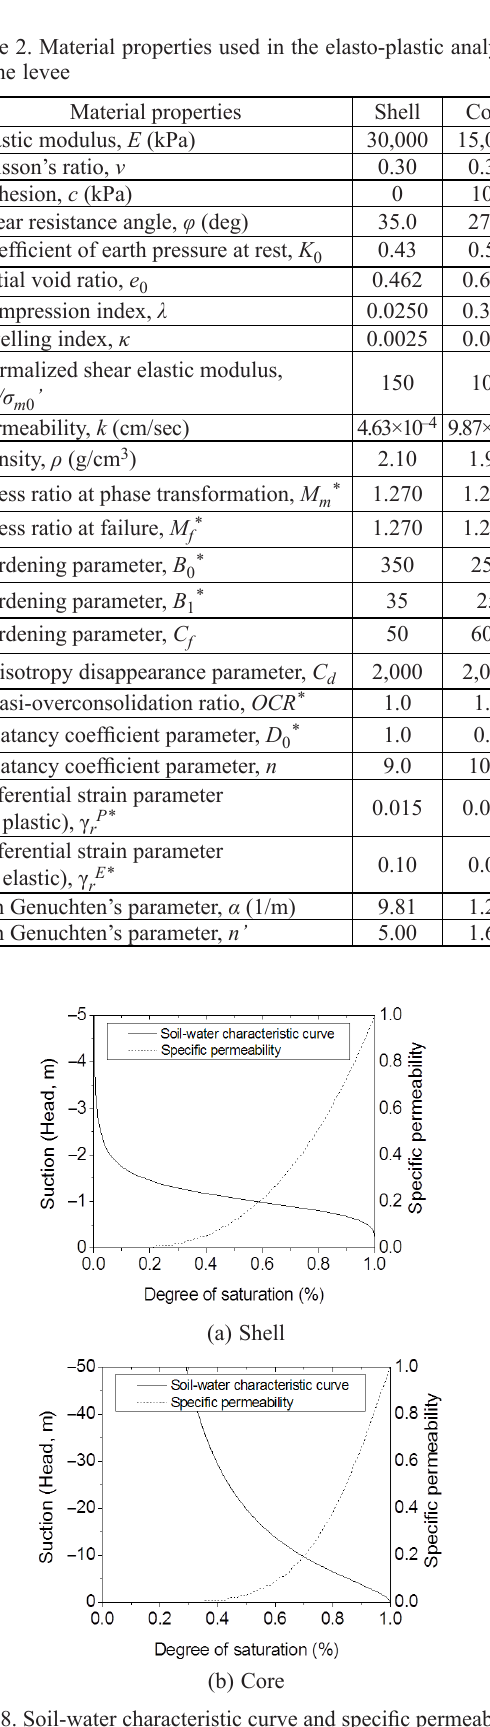
Fig. 7. Analytical model and boundary condition of the levee